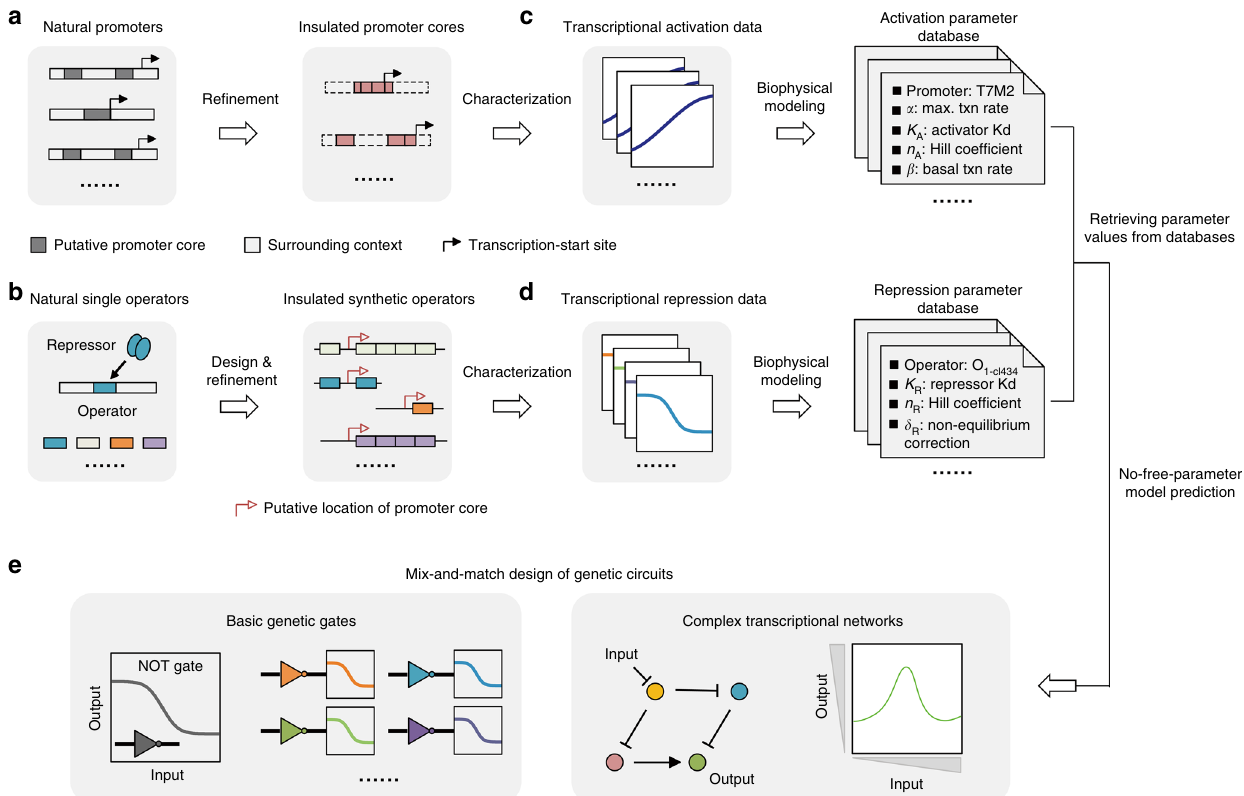
Fig. 1 Overview of the precise design of genetic circuits using insulated transcriptional elements. a Natural promoters from bacteria and phages were genetically re fi ned to identify insulated promoter cores (minimal promoters for which transcriptional activity is independent of sequence context). b Natural single operators were permuted and re fi ned to create synthetic operators with diverse transcriptional regulation properties, designed to be free of spontaneous promoter activity. c and d Insulated promoter cores c and synthetic operators d were experimentally characterized and parameterized as transcriptional activation- and repression-dependent parameter databases, respectively, via biophysical modeling. e Genetic circuits including both basic genetic gates and complex transcriptional networks can be precisely designed using insulated transcriptional